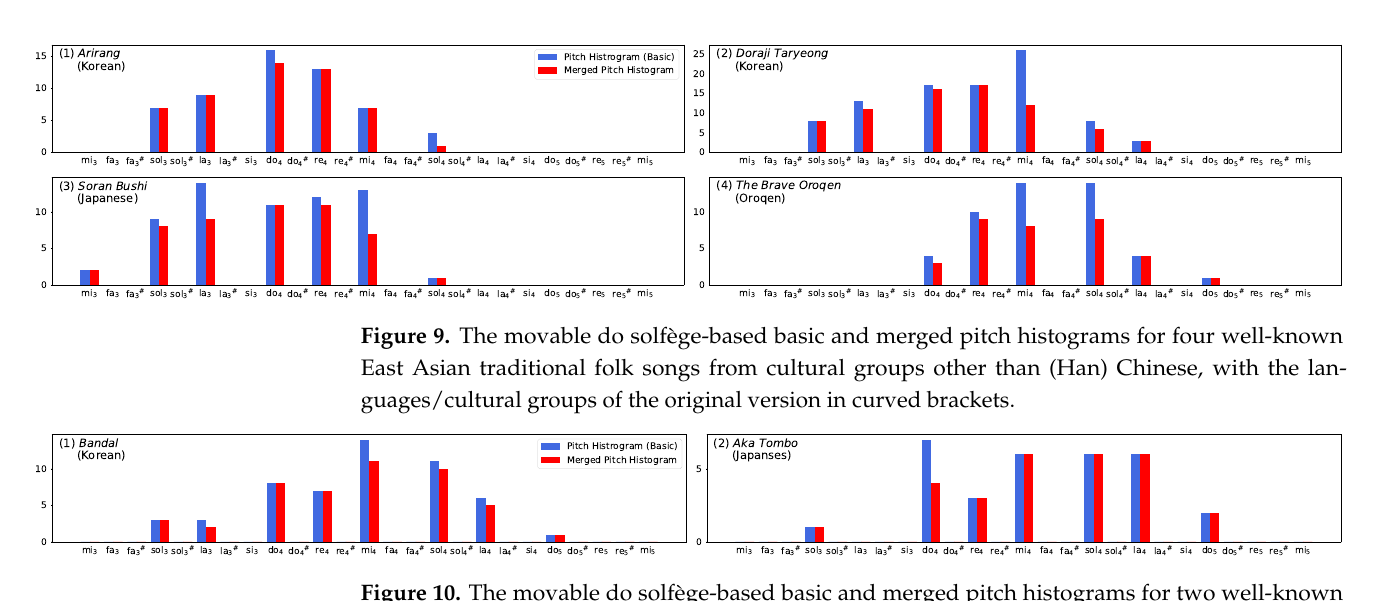
Figure 10. The movable do solfège-based basic and merged pitch histograms for two well-known traditional Korean and Japanese folk songs using the anhemitonic pentatonic scale without a perfect bell-shaped pitch distribution ( DoBell < 1), with the languages/cultural groups of the original version in curved